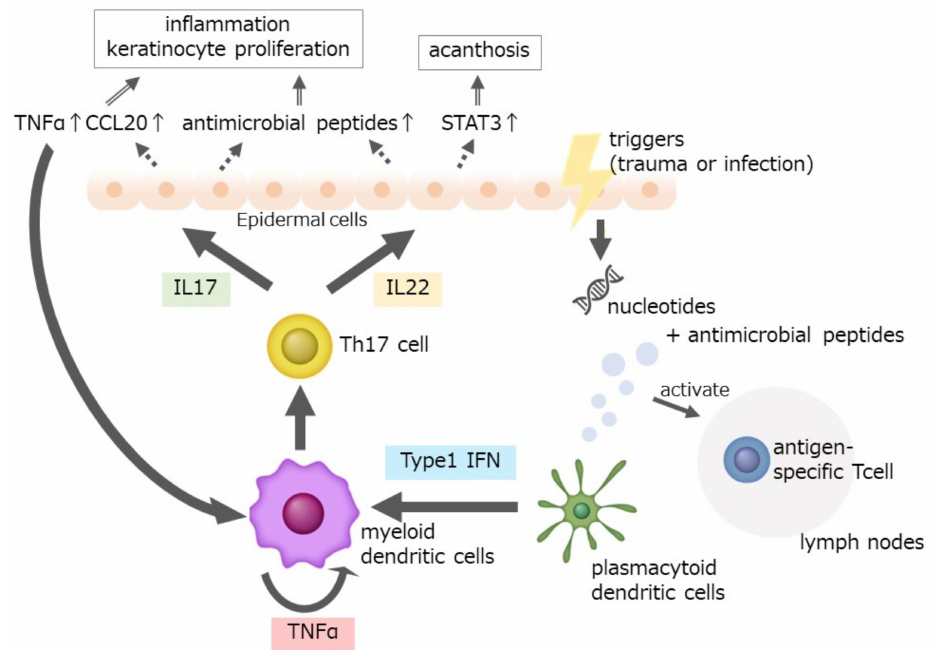
Figure 1. The pathogenesis of psoriasis. External triggers of trauma or infection induce host cell- derived nucleotides, which make a complex with keratinocytes-derived antimicrobial peptides. This complex is recognized by antigen-presenting cells, such as plasmacytoid dendritic cells, and activates antigen-specific T cell expansion in the skin and lymph nodes. Plasmacyte dendritic cell produces type I interferons, which activate the secretion of IL-23 and TNF by myeloid dendritic cells. These cytokines enhance the production of IL-17 and IL-22 by Th17 cells, which are activated by IL-1. IL-17 activates the production of TNF, CCL20, and antimicrobial peptides to enhance the inflammatory reaction in the skin and the proliferation of keratinocytes. The importance of these inflammatory cytokines has been proven by the specific cytokine inhibitors, which show strong anti-inflammatory action against psoriatic skin